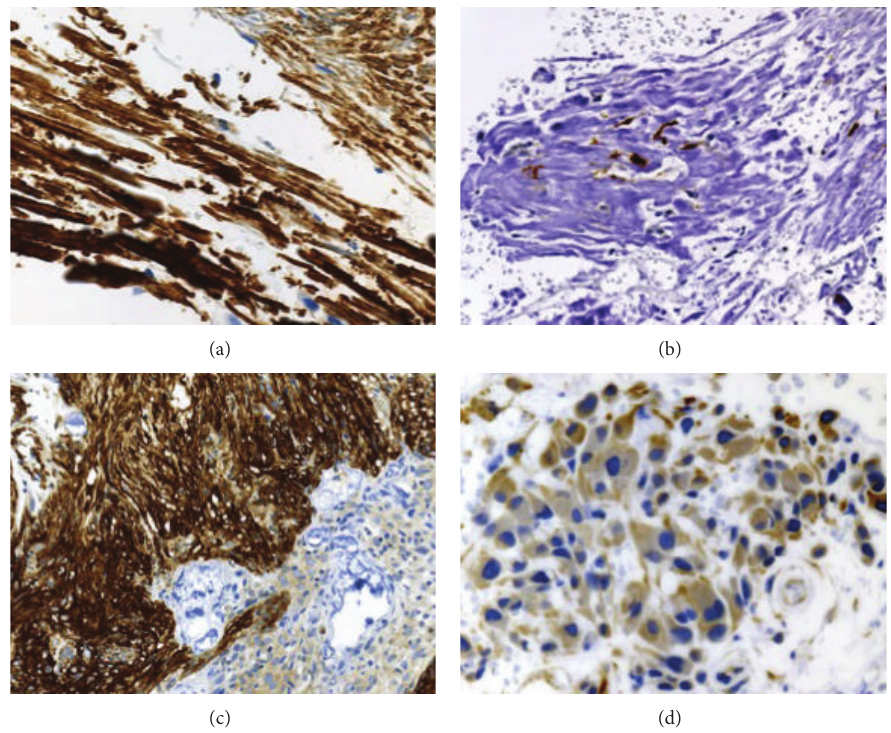
Figure 4: (a) Immunohistochemical findings showing strong positive staining for neurofilament (NF) in calcified areas. (b) Small foci in calcified areas are positive for S-100. (c) In noncalcified areas, spindle cells are positive for 𝛼 -smooth muscle actin (SMA). (d) Immature cells with hyperchromatic nuclei along with infiltrating mononuclear inflammatory cells are weakly positive for vimentin. Hematoxylin and eosin: (a) × 400; (b) × 200; (c) × 200; (d) ×